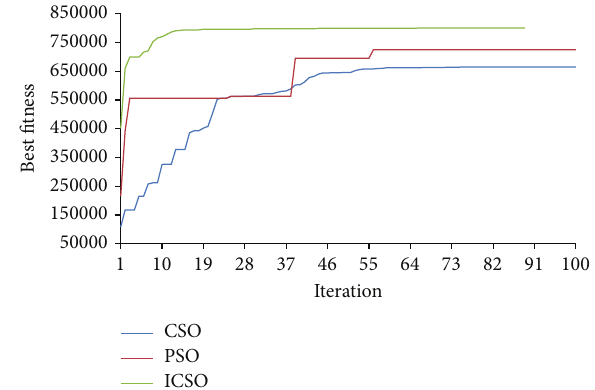
Figure 7: Comparison of convergence characteristics of CSO, PSO, and ICSO.